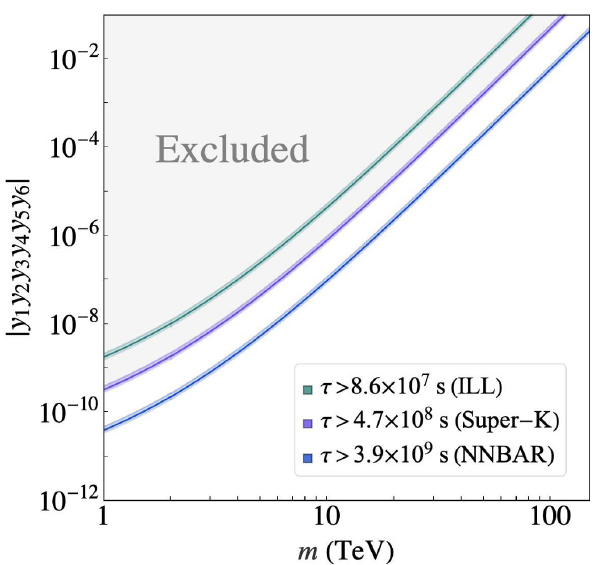
y 13 y 1 y 0 13 y 1 y 1 | ≡ | y 1 y 2 y 3 y 4 y 5 y 6 | and the mass 1 2 3 4 5 6